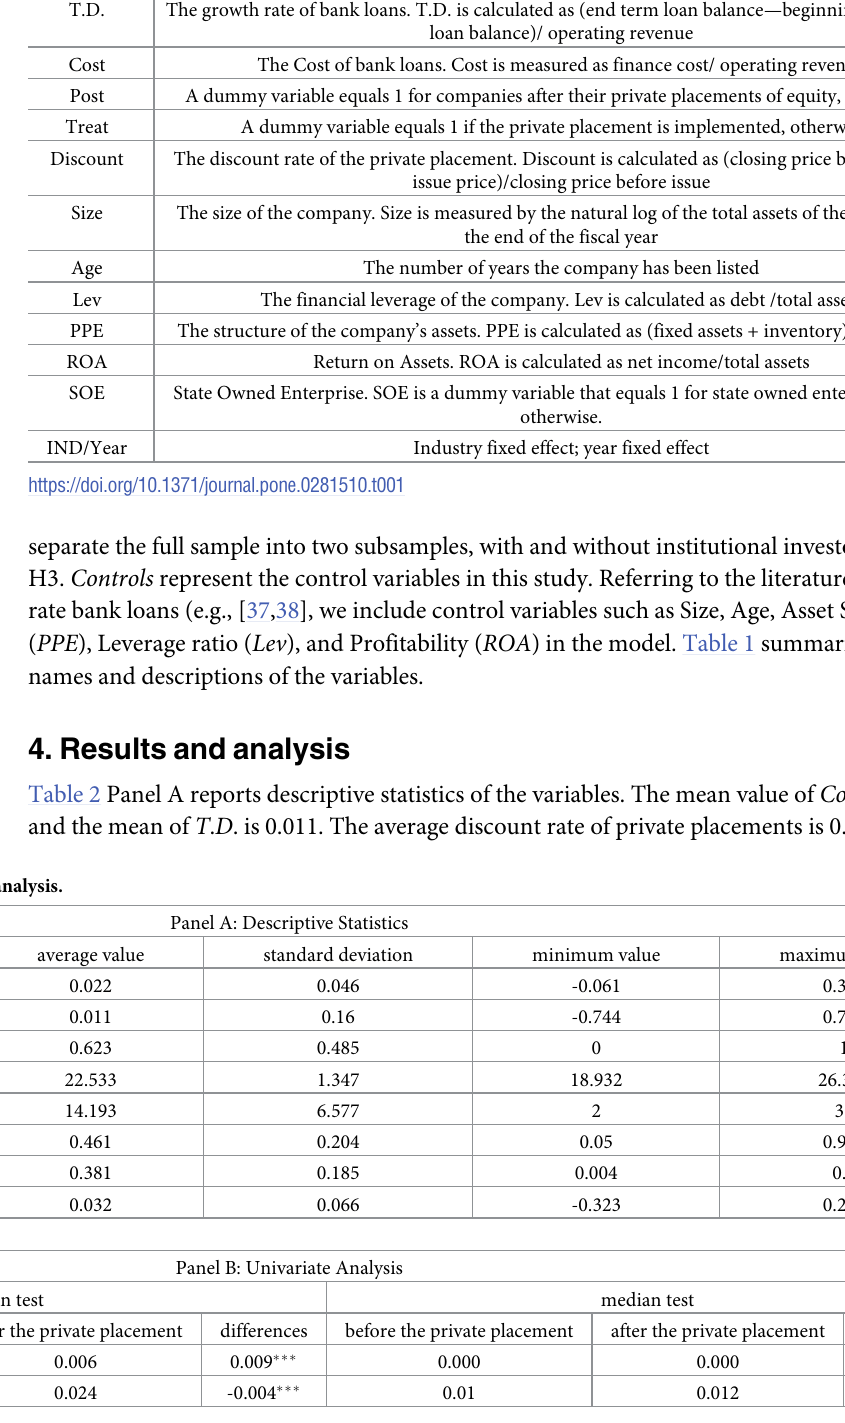
Table 1. Definitions and descriptions of major variables.